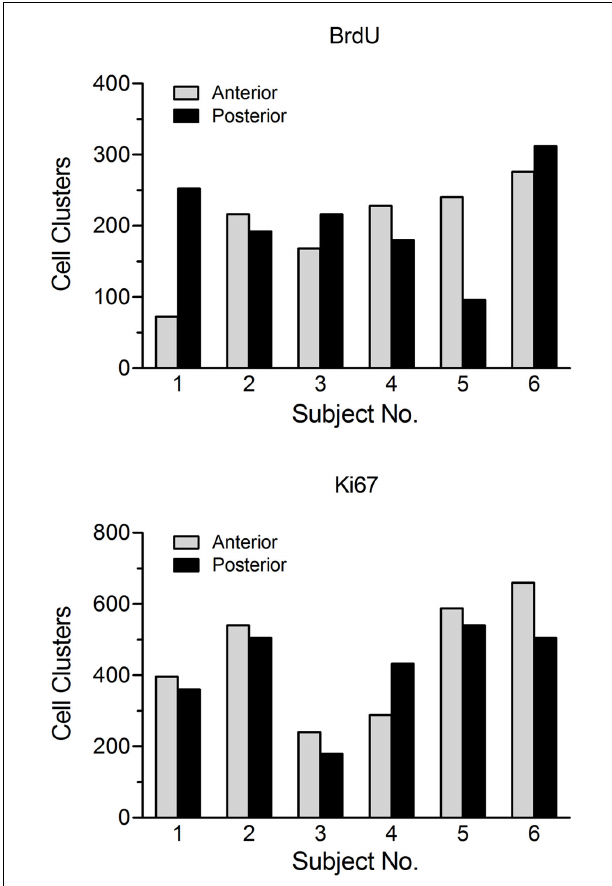
FIGURE 2 | Number of BrdU-positive and Ki67-positive cell clusters in the anterior (dorsal) versus posterior (ventral) dentate gyrus for a group of untreated adolescent ( ∼ 6week old) female Sprague-Dawley rats. This figure illustrates the large variability in both the total number and the regional distribution of labeled clusters within and between animals. Subjects were sacrificed 2h after a single injection of BrdU (200mg/kg, i.p.). Proliferating cells in the dentate gyrus were stained for both BrdU and the endogenous marker Ki67 using adjacent tissue sections from the same animal. For purposes of analysis, a cell cluster was defined as a grouping of three or more cells in close proximity ( ∼ 5 μ m) to each